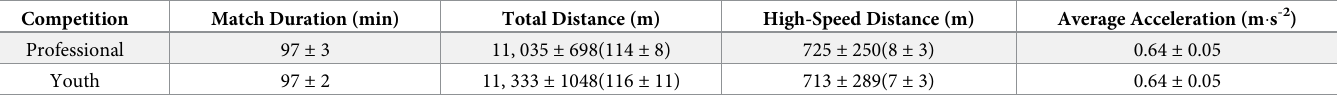
Table 1. Absolute and relative physical output total match averages. Data presented as mean ± SD. Data in brackets indicate relative distances covered (m � min -1 ). Match duration is inclusive of added time.